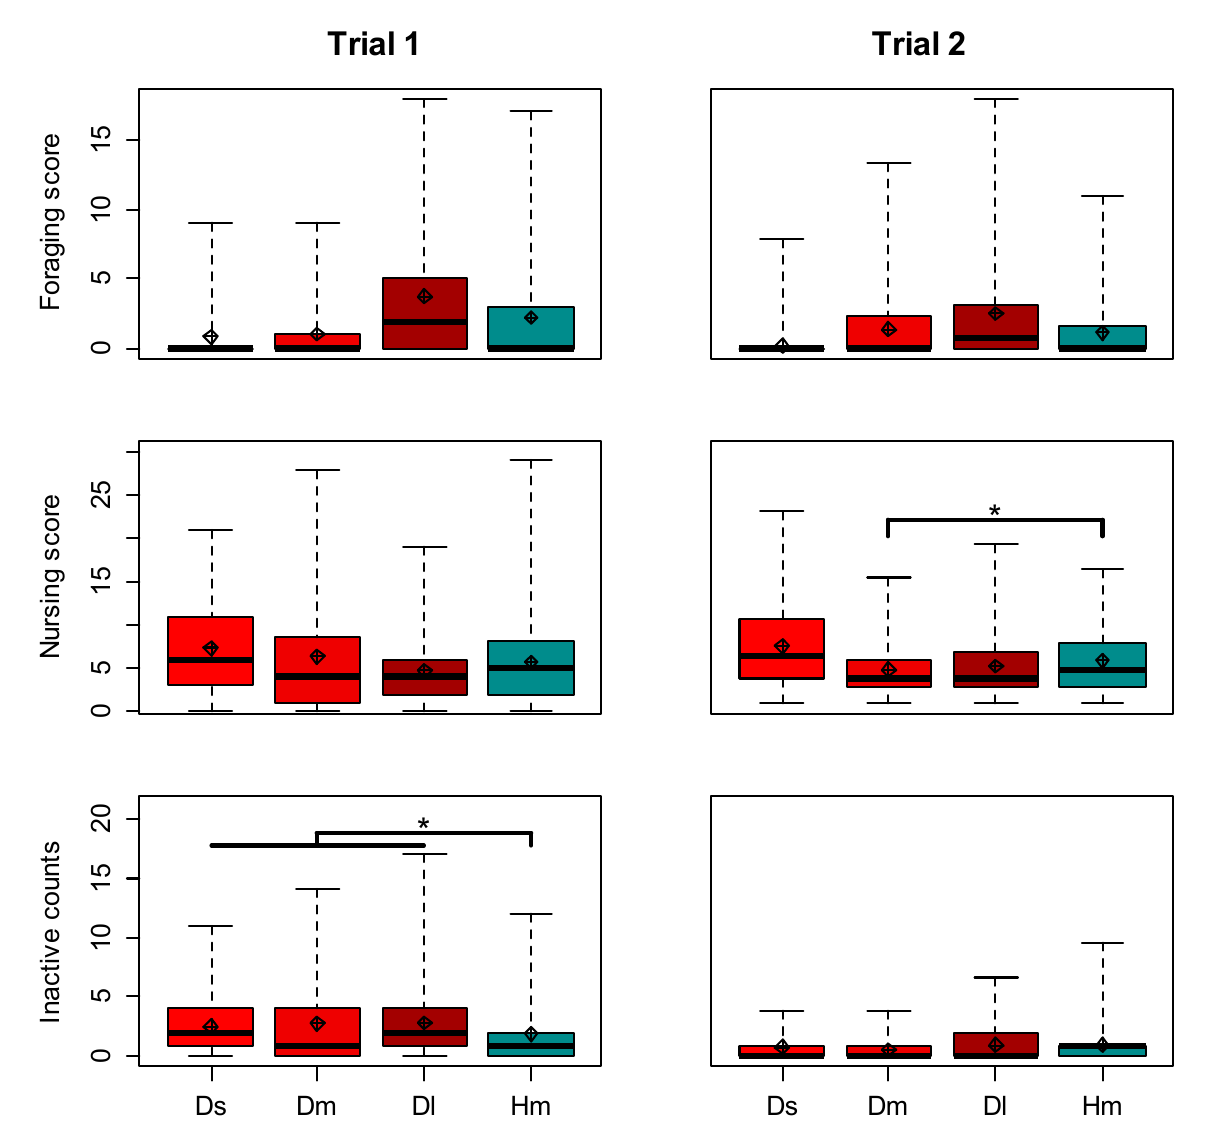
Figure 6. Worker foraging, nursing, and inactivity as function of body size and colony size diversity. Foraging score in upper row calculated by summing records for leaving the nest, returning to the nest without pollen and returning to the nest with pollen (see Figure S2 for more details). Nursing count in middle row and Inactivity counts in lower row based on records of tending brood or standing with no obvious task, respectively. Ds = small workers from diverse colonies; Dm = medium workers from diverse colonies; Dl = large workers from diverse colonies; Hm = medium workers from homogeneous colonies. Diamonds = means; thick black lines = medians; boxes = interquartile ranges; dashed whiskers = ranges. Only significant comparisons shown, among Wilcoxon tests comparing the counts (across all workers or across only medium workers, as shown) between the two treatments. * p <